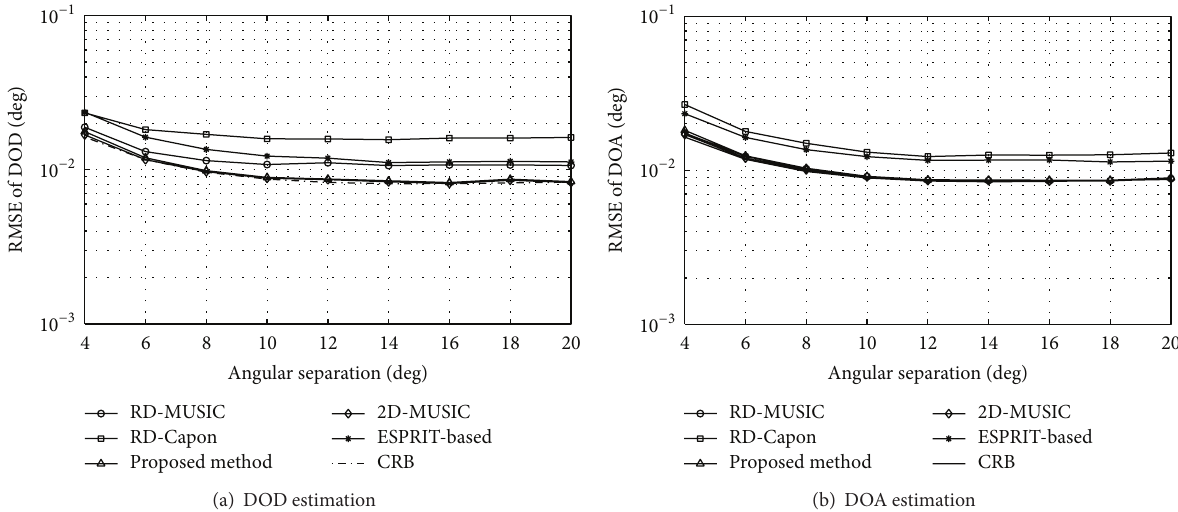
Figure 5: RMSEs of angle estimation against angular